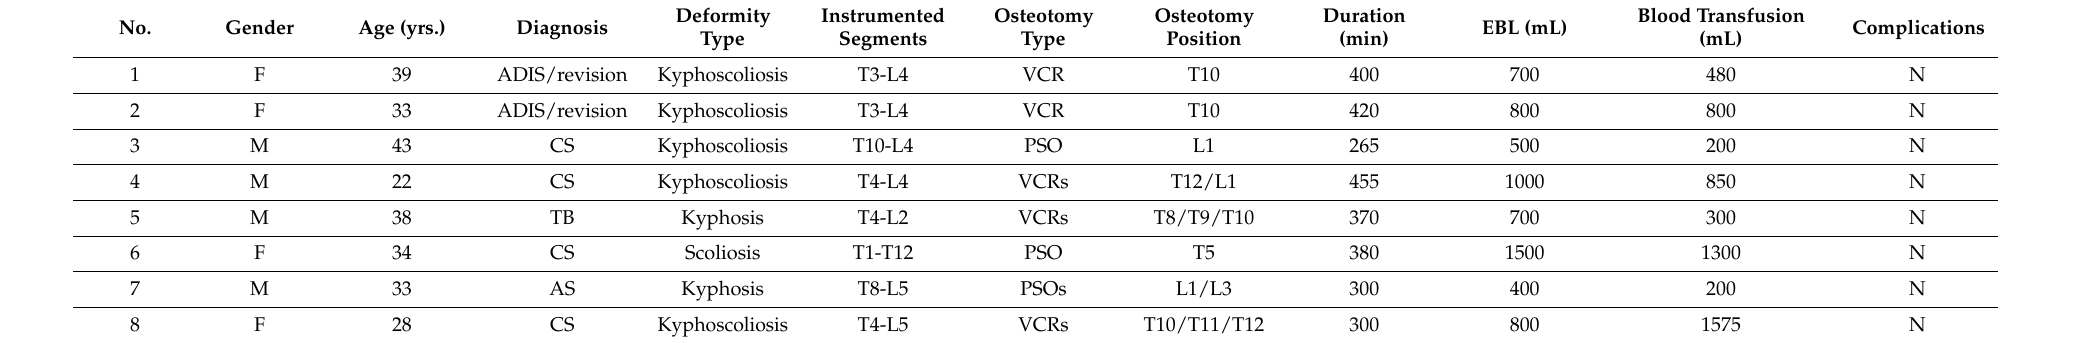
Table 1. General and operative parameters of included patients.